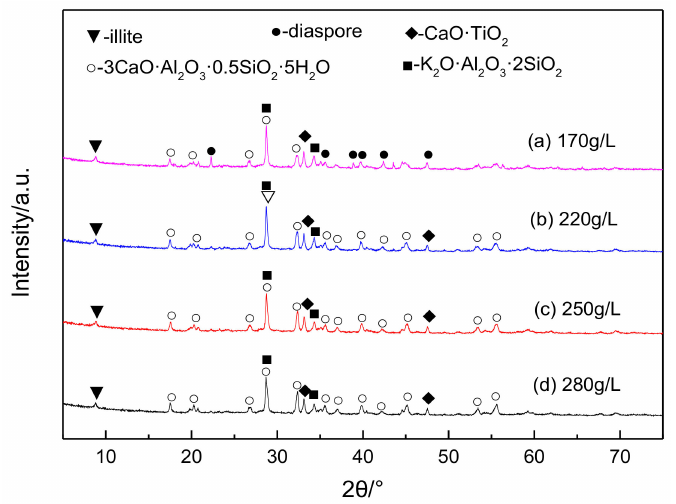
Figure 5. XRD patterns of red mud with different caustic concentrations (conditions: T = 265 ◦ C, mass ratio of CaO/ore = 8%, t = 1 h).